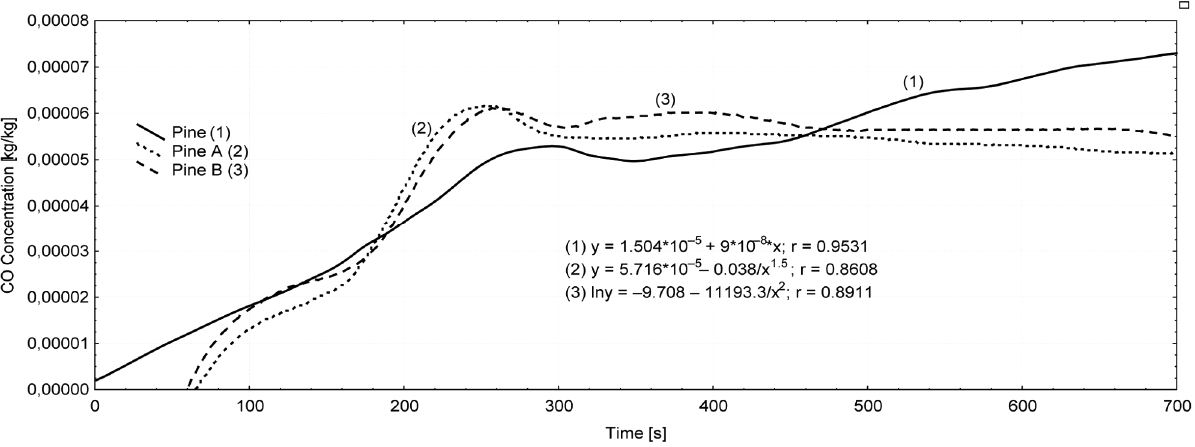
Fig. 8. Alternation of average CO concentration measured by the sensor in the centre of the compartment at the height of 1.4 m ob- tained during flame combustion of tested specimens subjected to time: (1) – non-treated pine timber specimens; (2) – pine timber specimens treated with A; (3) – pine timber specimens treated with